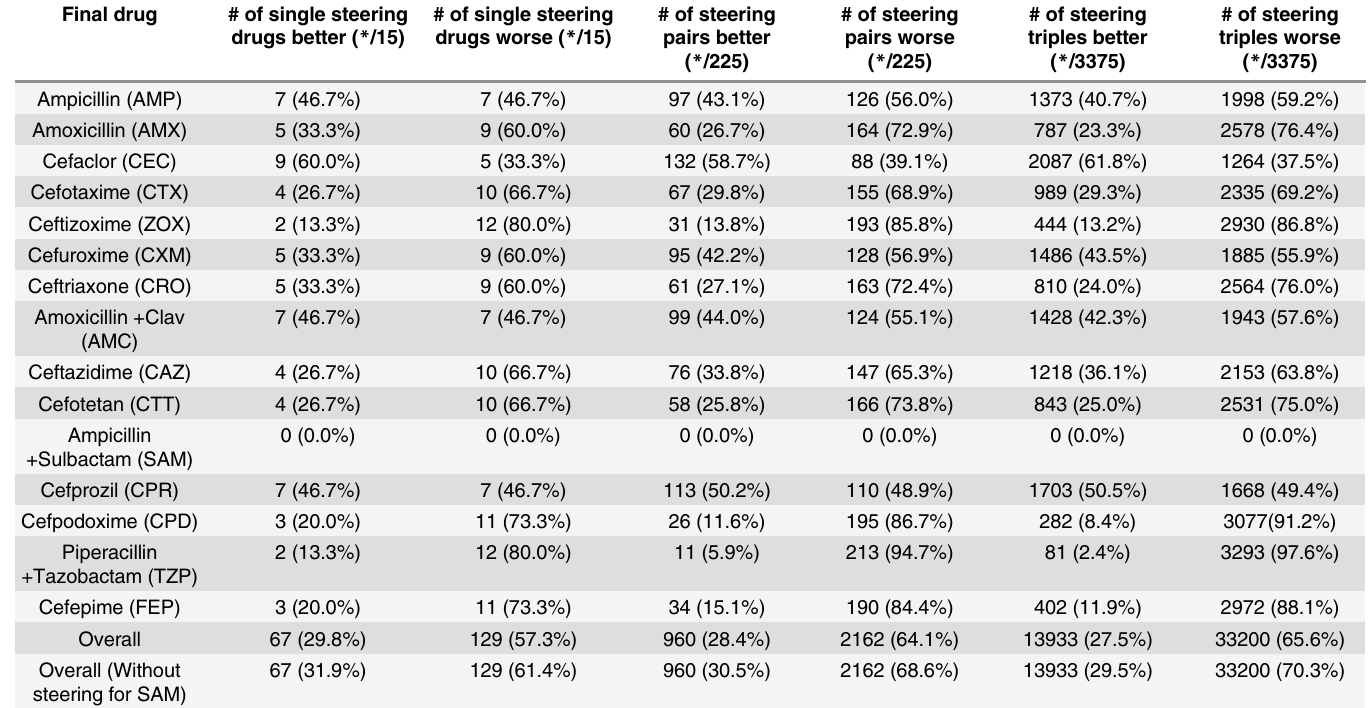
Table 3. Analysis of all possible steering sequences of length one, two and three.